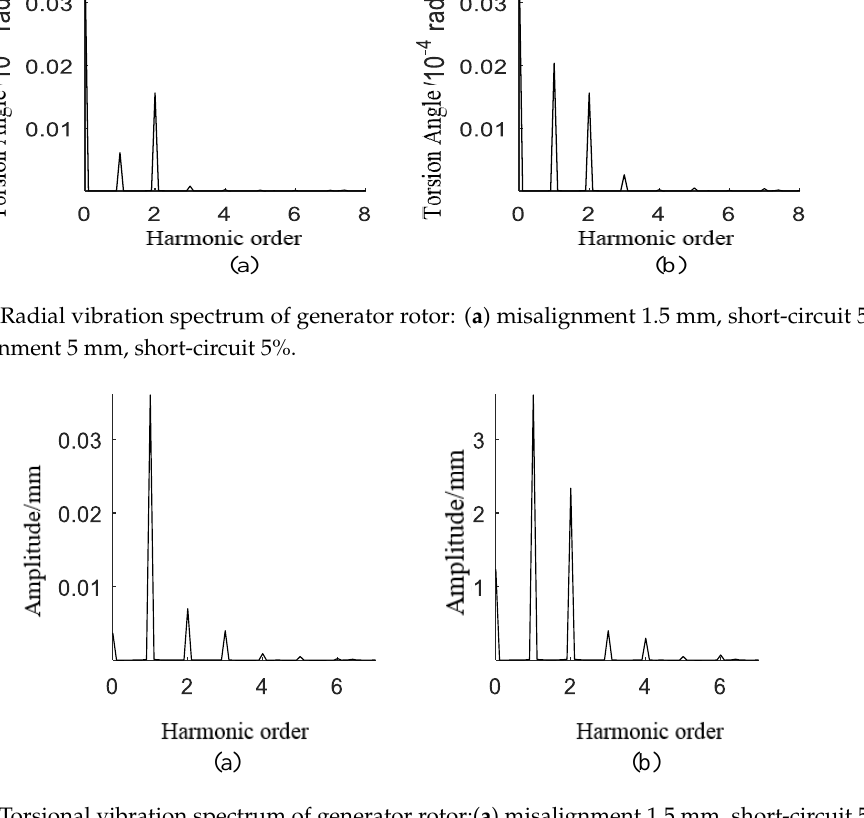
Figure 15. Torsional vibration spectrum of generator rotor:( a ) misalignment 1.5 mm, short-circuit 5%; ( b ) misalignment 5 mm, short-circuit 5%.